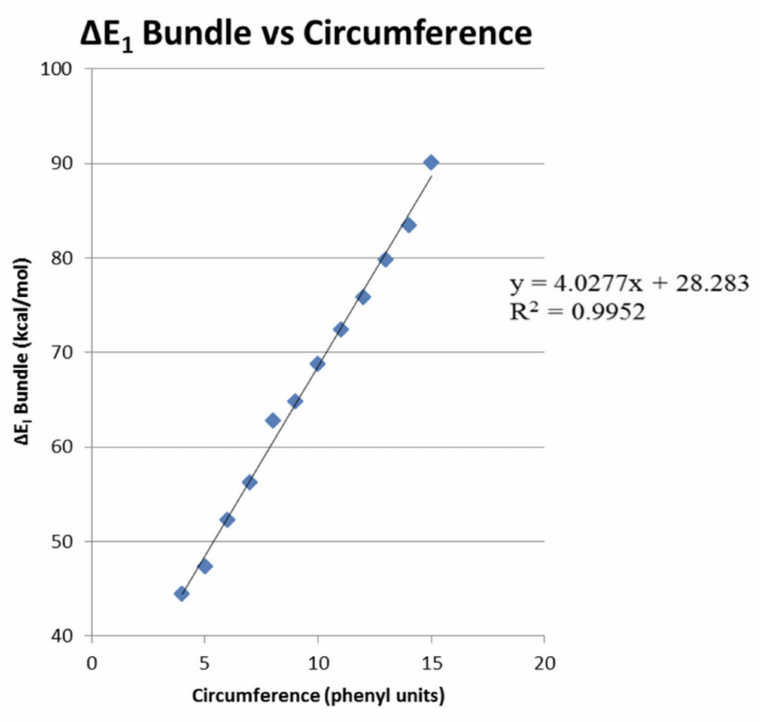
Figure 7. Average pairwise binding energy found in bundles versus the circumference of CNTs in rings. For comparison, simple pairs were assembled for each of the varied CNT circumfer- ences from (4,4) to (15,15). Each aligned pair was constructed three times, and the three trials done for each different circumference were averaged. These average results